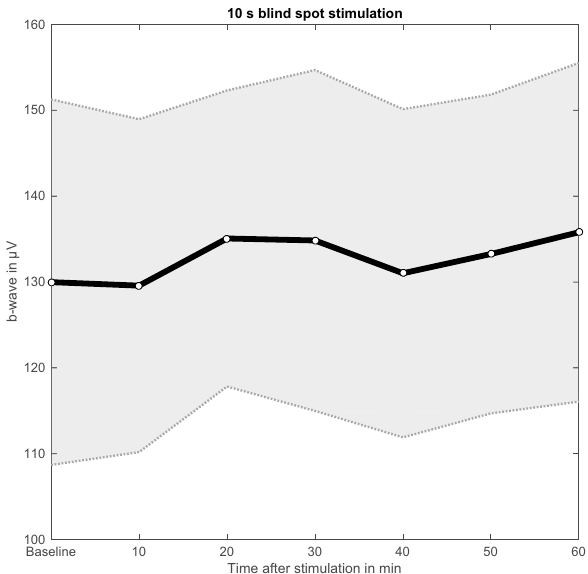
Figure 3. Mean and standard error of the mean (SEM) of the b-wave amplitude (µV) at baseline and 10, 20, 30, 40, 50, and 60 min after the 10 s blue light stimulation protocol.